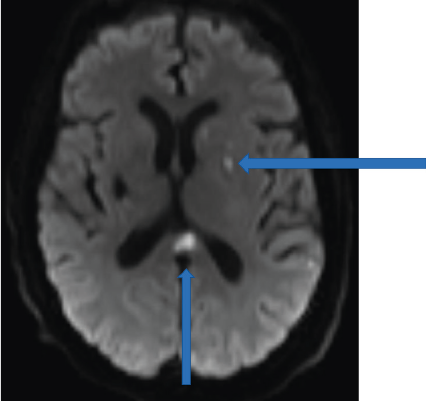
Figure 2: MRI diffusion weighted imaging with acute infarcts in the splenium of the corpus callosum and the posterior superior frontal